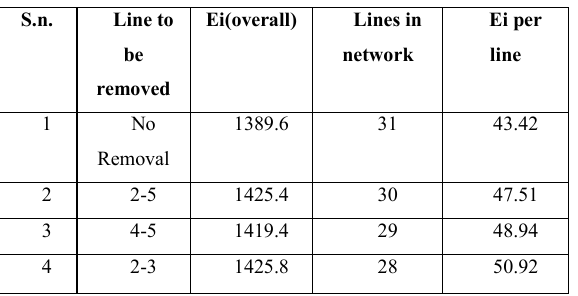
TABLE 3. PATTERN FOR ECONOMIC INDEX (Ei) S.n.